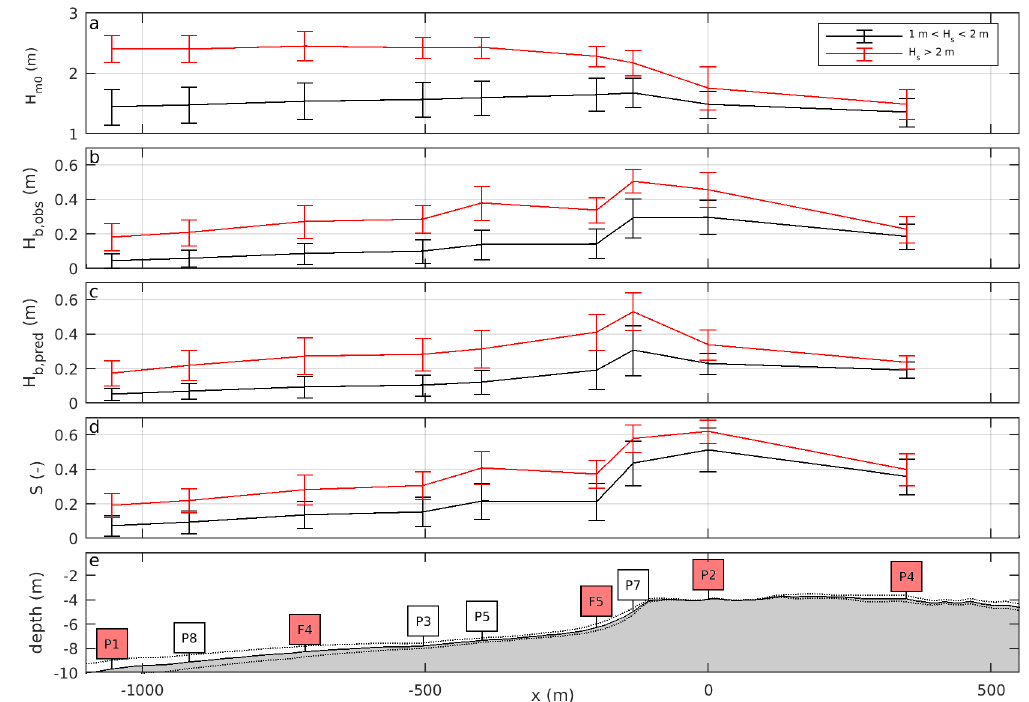
Figure 4. The spatial evolution of averaged wave statistics: H m 0 ( a ), H b , obs ( b ), H b , pred ( c ), and S ( d ) along the main transect ( e ) for Group 1 (black lines, 1 m ≤ H m 0, P 1 ≤ 2 m) and Group 2 (red lines, H m 0, P 1 ≥ 2 m). The error bars indicate ± one standard deviation. For a description of the